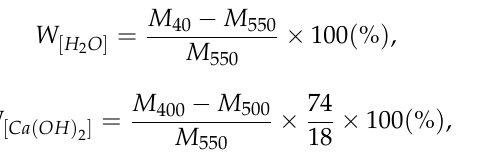
Figure 6. TGA curves of the produced MK blended pastes with BTE after 7 days of sealed curing: ( a ) TGA curves of pastes made with MK; ( b ) DTG curves of pastes made with MK; ( c ) TGA curves of pastes made with MK and BTE; ( d ) DTG curves of pastes made with MK and BTE. According to the DTG results, the mass loss between 40 ◦ C and 550 ◦ C was regarded as the amount of bound water using Equation (1). The weight loss related to the decomposition of CH can be measured by integrating the peak area between 400 ◦ C and 500 ◦ C in DTG curves [36]. This tangential method can correct the overestimation of CH and exclude the weight loss caused by the ongoing decomposition of C–S–H in this temperature interval [38]. Then, the amount of CH can be calculated on the basis of the molecular masses of CH (74 g/mol) and water (18 g/mol), as given by Equation (2). The quantifications of the bound water and CH were normalized to the dry weight of binders at 550 ◦ C [39].